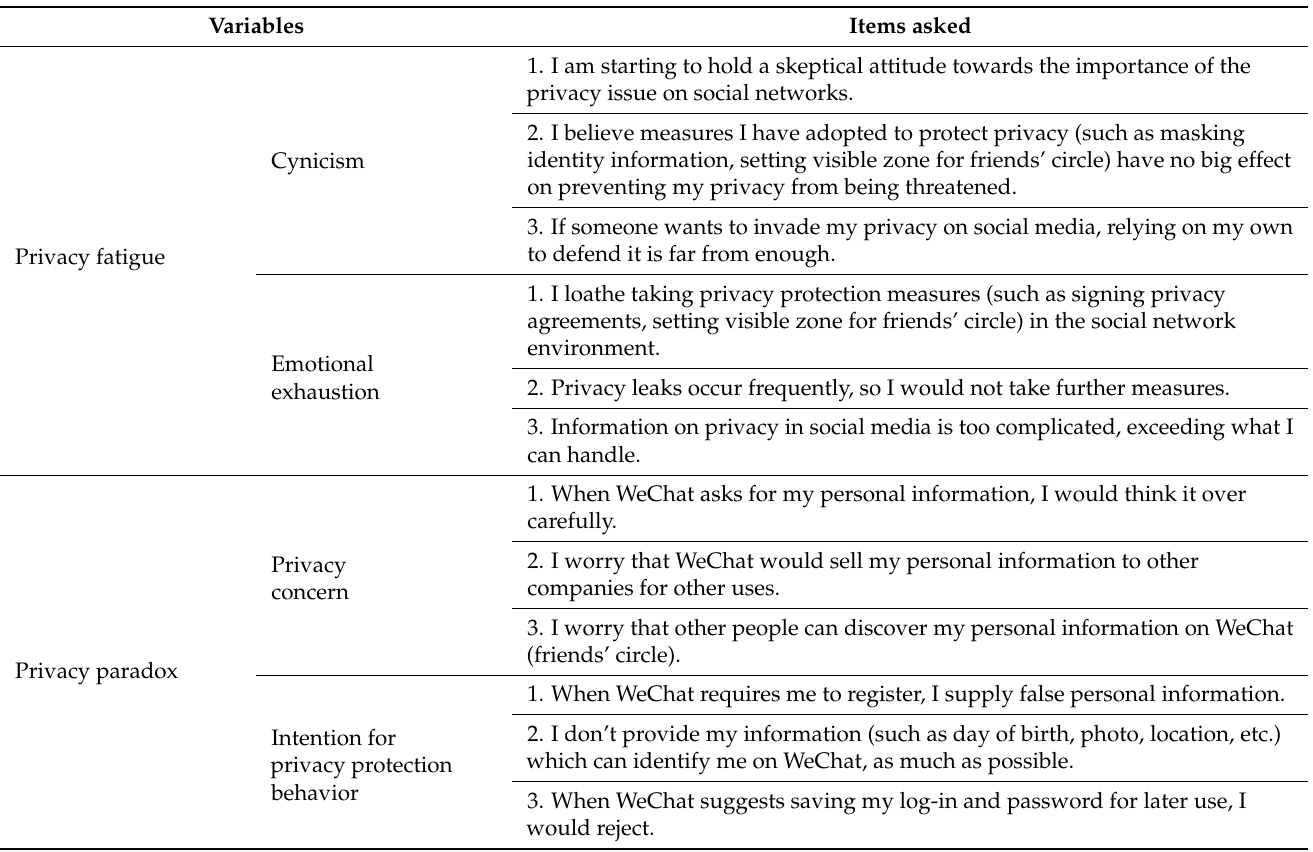
Table 1. Measurement indicator system of core